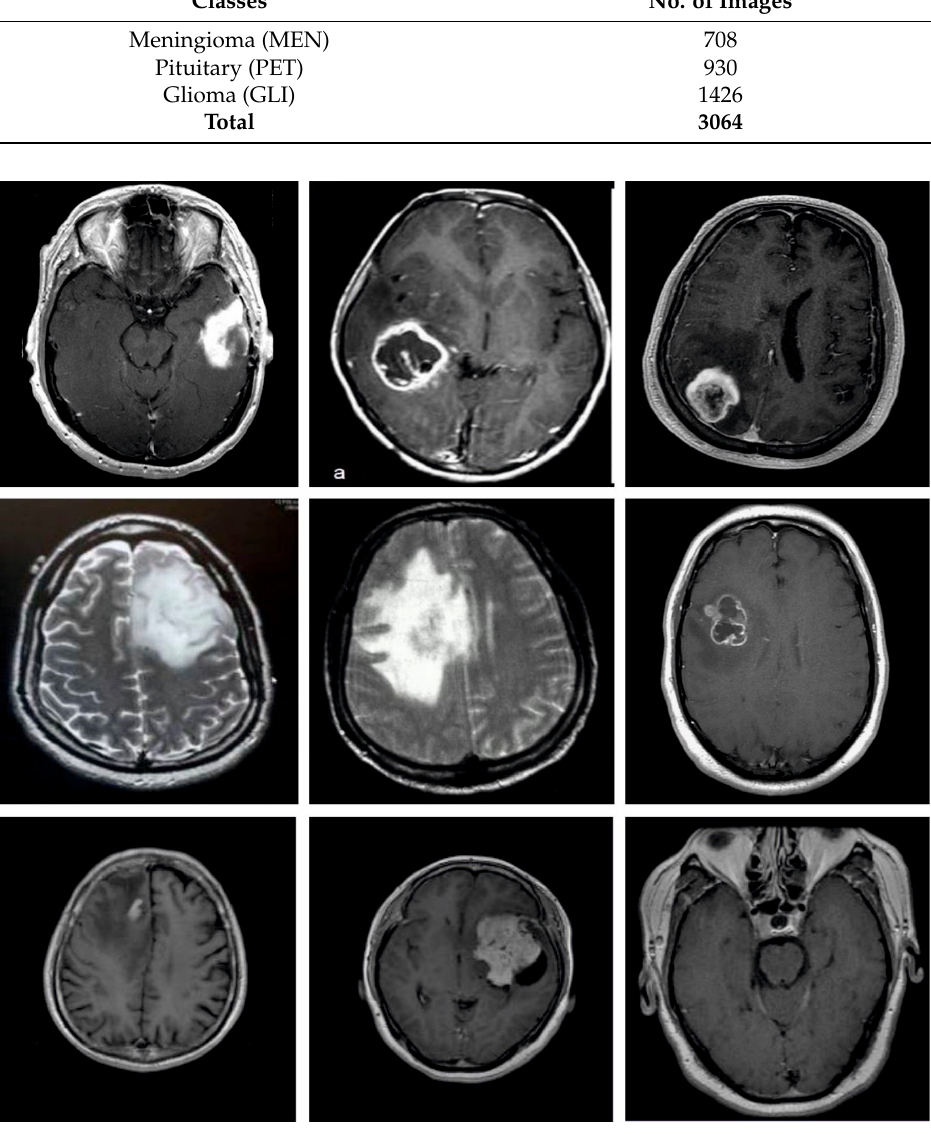
Figure 3. Sample Images.